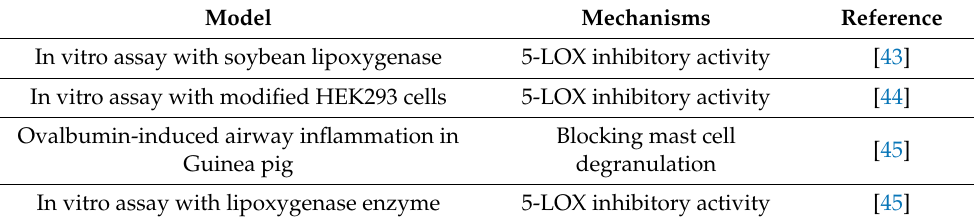
Table 1. Summary of the thiophene-based compounds acting as COX and/or LOX